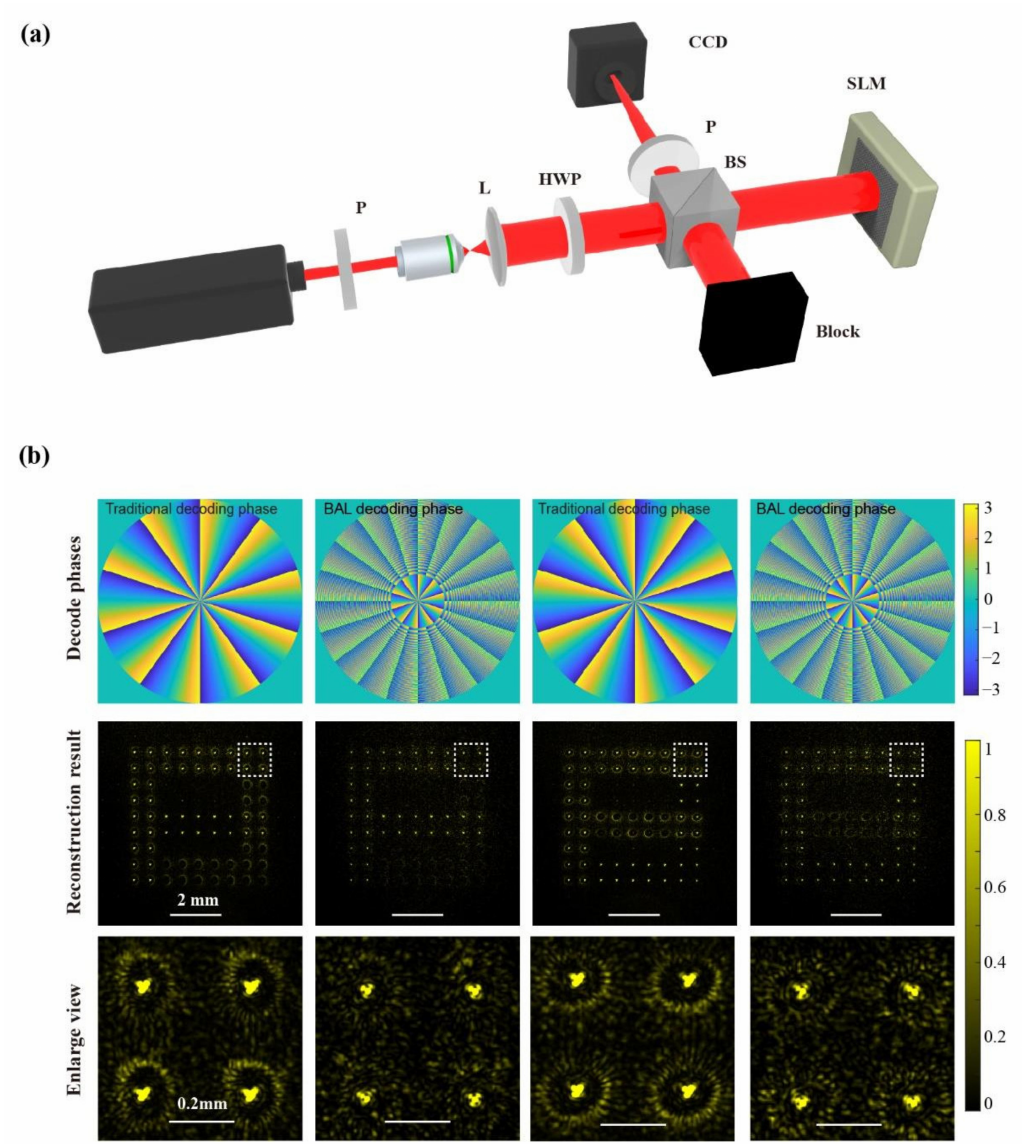
Figure 5. Experimental implementation. ( a ) Optical setup. P: linear polarizer; L: lens; BS: beam splitter; HWP: half-wave plate. ( b ) Decoding the OAM multiplexing hologram with traditional and BAL decoding methods with the same exposure time, the top row of pictures is the decoding phase, and the following two lines of pictures are the decoding